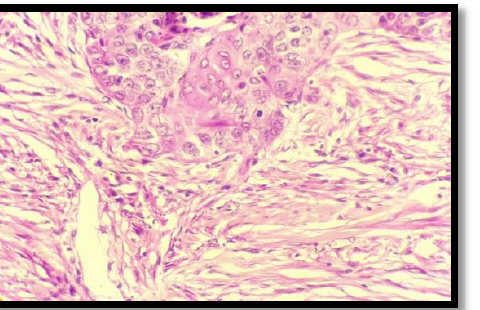
Figure 2: (x200): Histological section of well differentiated squamous cell carcinoma with low stromal